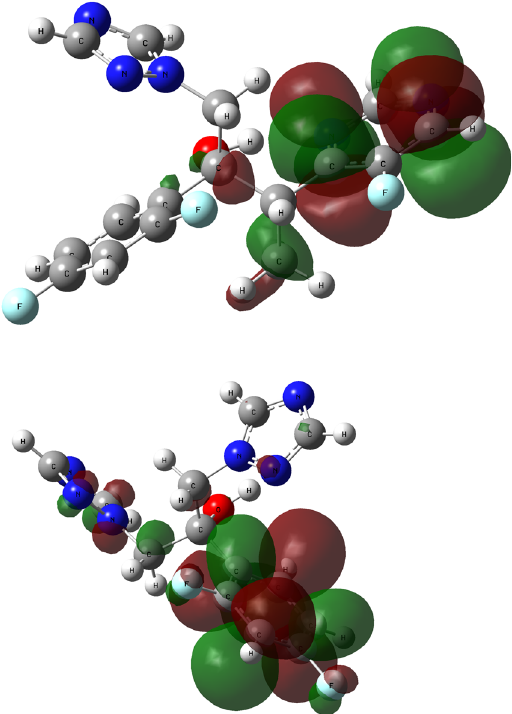
Figure 9: The LUMO orbitals generated for compound 1 ( up ; rotamer optimized at the PBE1BE /6 - 31G ( d,p ) level of theory in methanol ) and 2 ( down ; rotamer optimized at the B3LYP/6 - 31G ( d,p ) level of theory in methanol ) ; vertical excited states calculated at the func - tional/6 - 311 ++ G ( 2d,3p ) level of theory ( functional: PBE1BE or B3LYP for 1 or 2 , respectively )